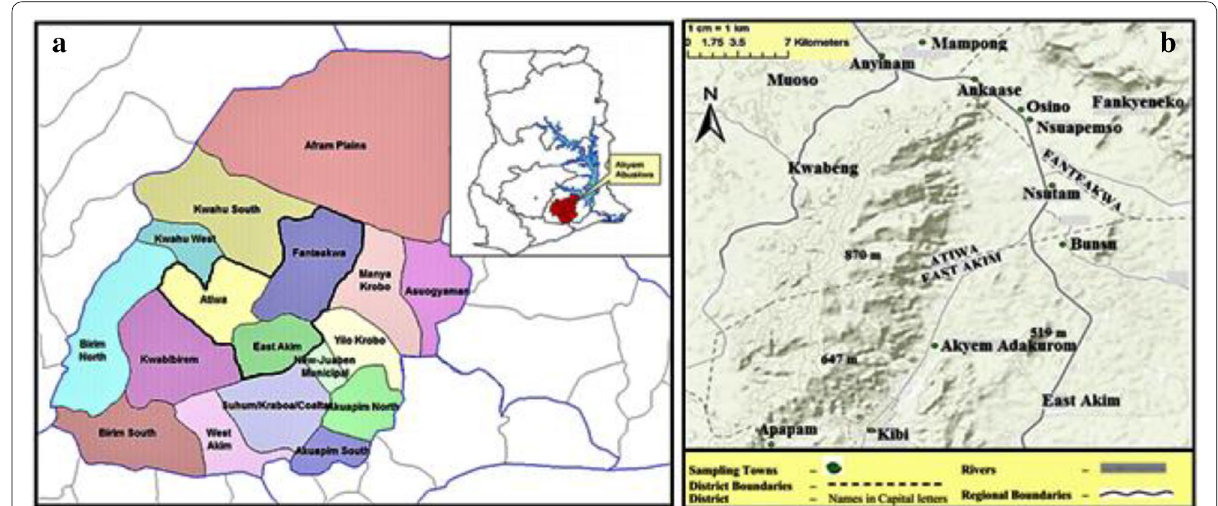
Fig. 1 Map showing a the location of the settlements within the Birim River basin and b the sampling